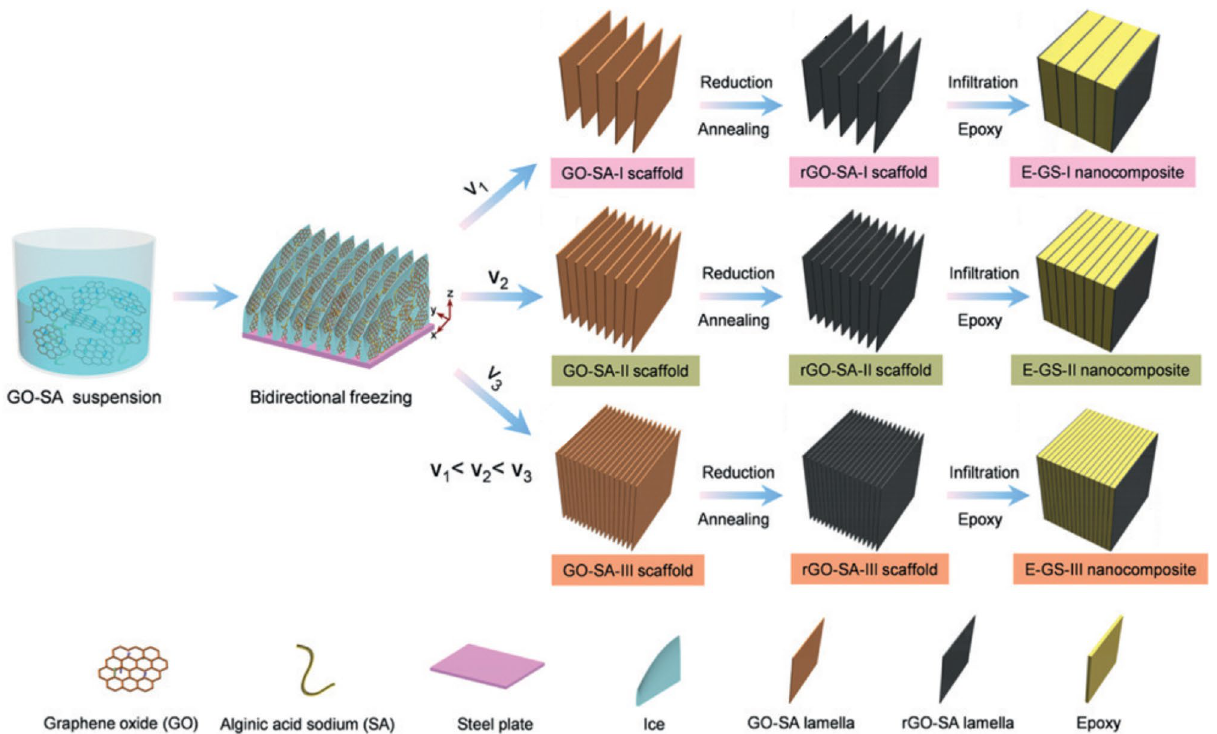
Fig. 13 Effect of freezing rate on GA layer spacing